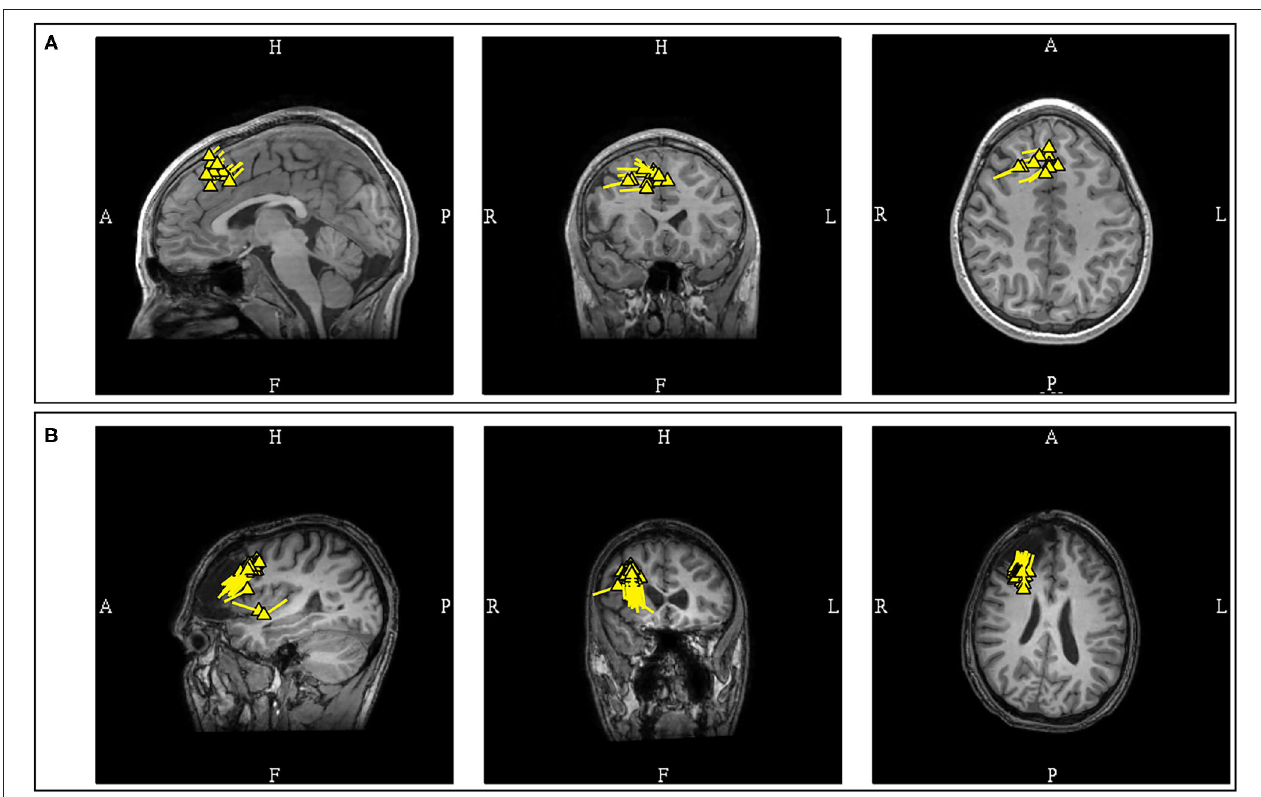
FIGURE 11 | (A) MEG-MRI coregistration summary demonstrating predominantly interhemispheric frontal dipoles. The uniform vector orientation toward the right suggests a right hemispheric source lateralization. Intracranial recording confirmed the finding, with seizure freedom for 5-years after right frontal resection. (B) This patient developed late seizure recurrence, with tight and uniform dipole cluster at the resection margin. Note the dipole orientation suggestive of positivity at the resection surface as a result of disruption of normal cortical laminar